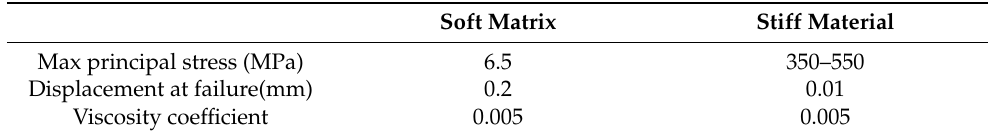
Table 2. Materials failure parameters.